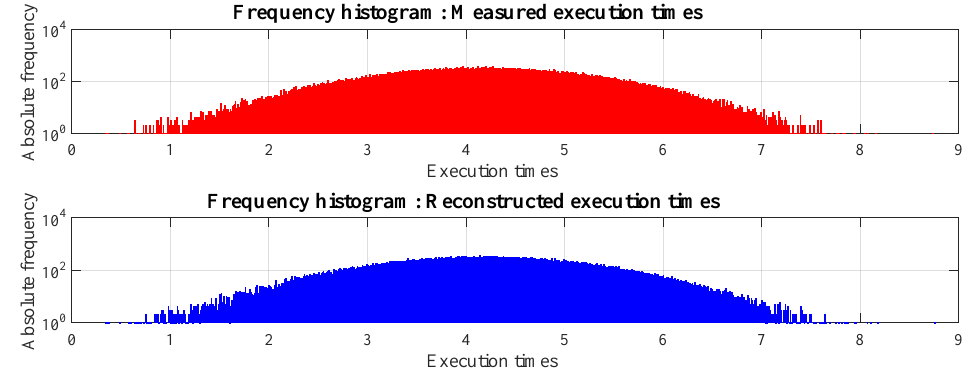
Figure 18. Measured and reconstructed execution times frequency histogram (using log scale on x - and y -axis).